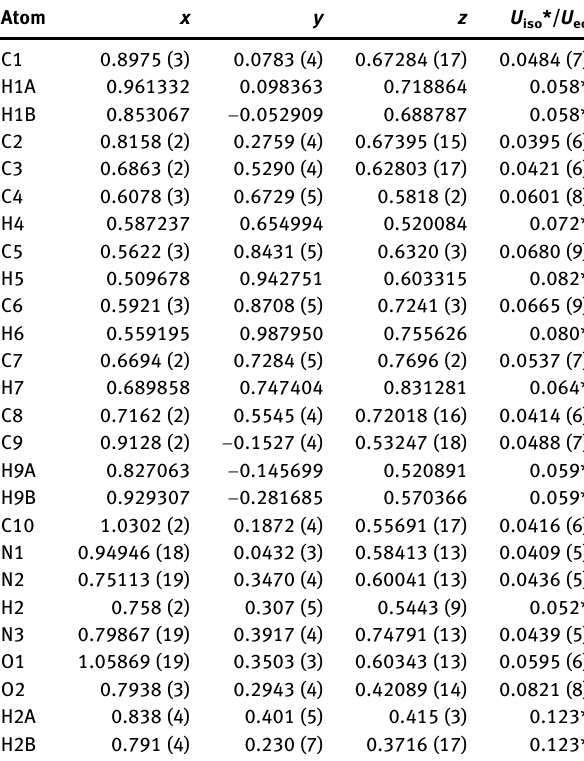
the piperazine-2,5-dione centroid. Due to the conjugate ef- fects of the two carbonyl groups, the six-membered pipera-